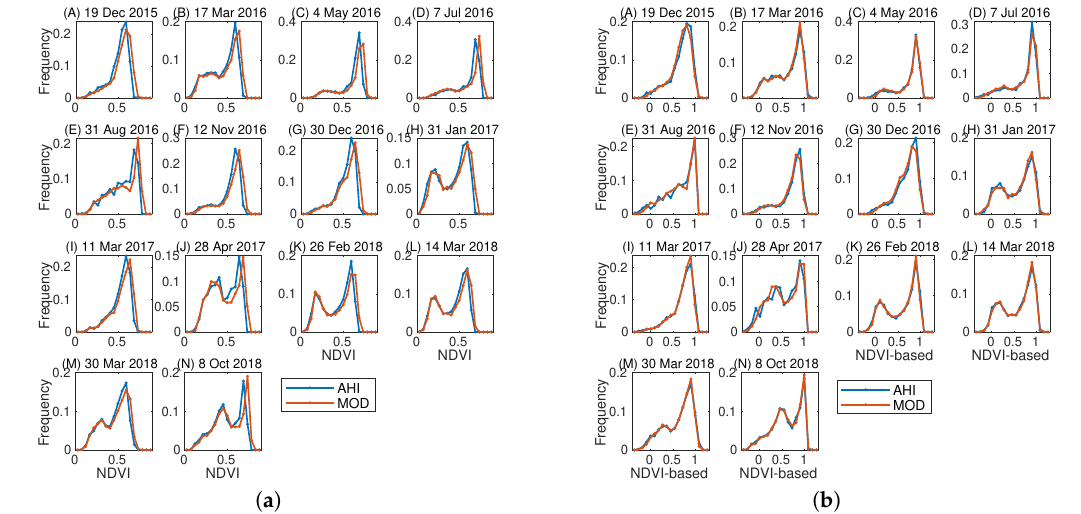
Figure 9. ( a ) Relative frequency distributions of the AHI and MODIS NDVIs in the Tokai region. ( b ) NDVI-based index.